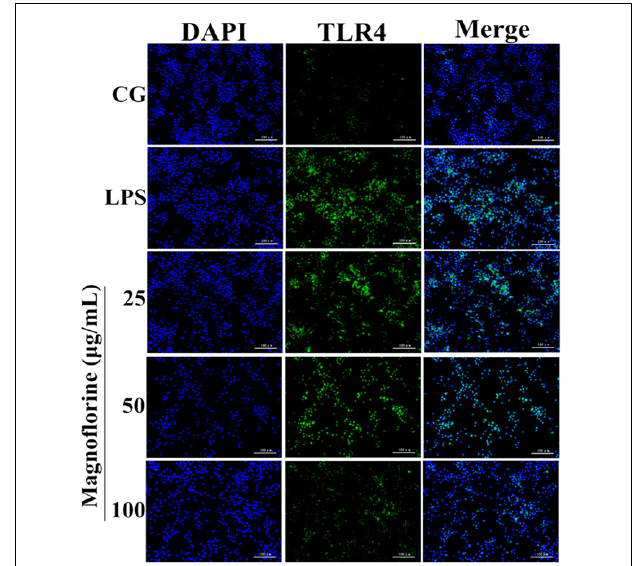
FIGURE 5 | Effects of magnoflorine on the expression level of TLR4 protein. Immunofluorescence staining was performed to identify the expression of TLR4 ( × 200), scale bar = 100 µ m. Blue spots represent cell nuclei, and green spots indicate TLR4 staining. CG is the control group. LPS is the LPS-stimulated